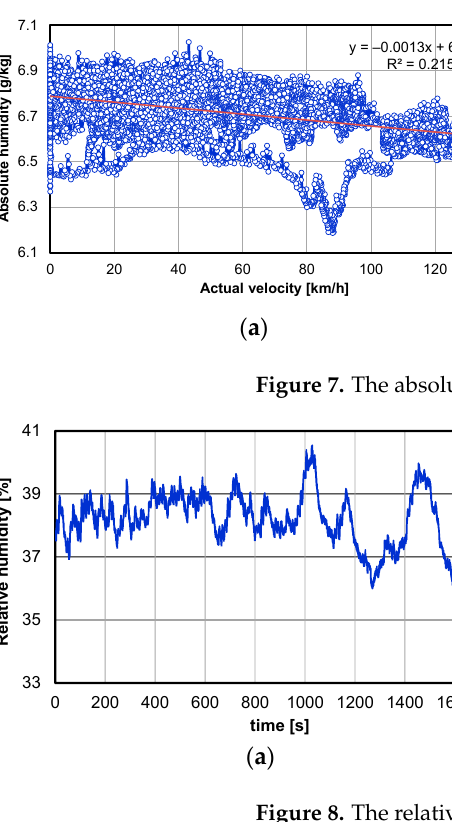
Figure 8. The relative humidity versus time for: ( a ) plug-in; ( b ) HEV.